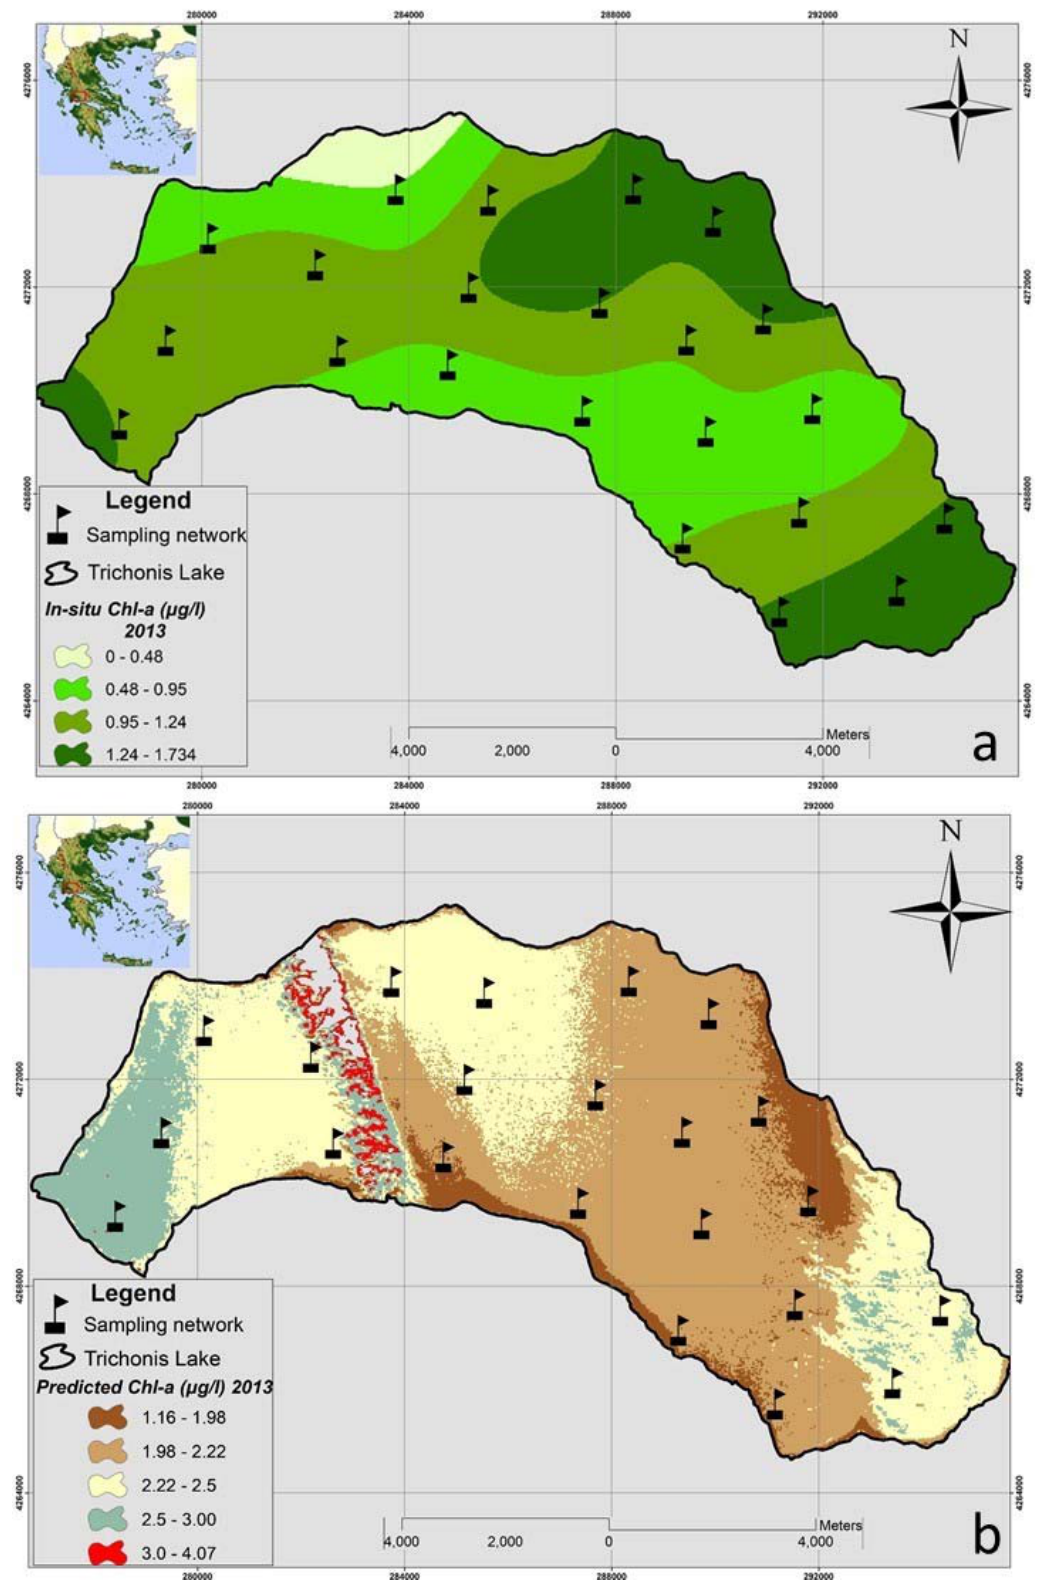
Figure 7. ( a ) In ‐ situ Chl ‐ a ( μ g/L) spatial distribution of 2013 and ( b ) Satellite derived Chl ‐ a ( μ g/L) of Figure 7. ( a ) In-situ Chl- a ( µ g/L) spatial distribution of 2013 and ( b ) Satellite derived Chl- a ( µ g/L) of 2013 along the Trichonis Lake, after applying the satellite ‐ predictive algorithm using L8 bands. 2013 along the Trichonis Lake, after applying the satellite-predictive algorithm using L8